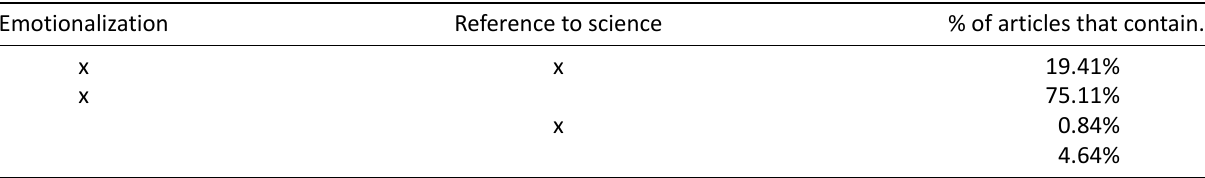
Table 6. The use of emotionalization and references to science in the articles analyzed.